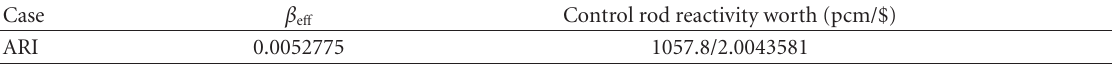
Table 2: Values of β e ff and ejected control rod reactivity worth.